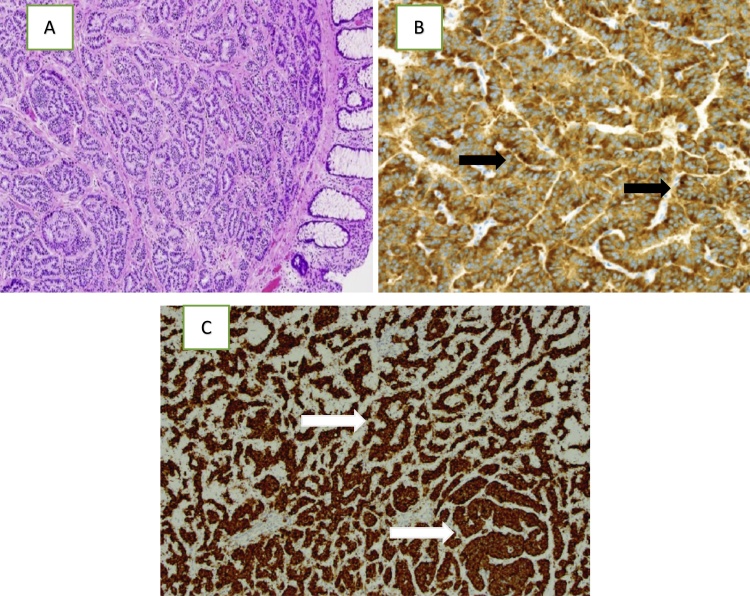
Histopathology slide showing: A) NET invading the submucosa (Hematoxylin-eosin staining, 4x); B) positive result for chromogranin A in neoplastic cells (the nuclei are blue and cytoplasm was brown) (black arrows); C) positive brown-stained cytoplasm for synaptophysin in neoplastic cells (white arrows).